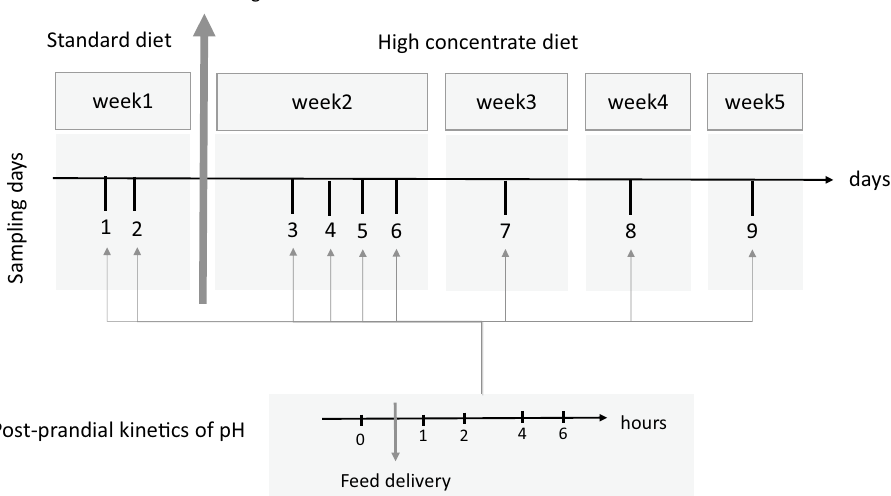
Figure 1. Experimental design. Goats were fed the standard diet in the first week (the first 2 days). Their diet was changed to the high-concentrate diet in the next 4 weeks of experimentation (Days 3 to 9). At each sampling day, pH was recorded before and 1, 2, 4 and 6 h after feed delivery. The presence of two embedded dynamics can be seen in the scheme: one for post-prandial kinetics of pH, the second for the sampling days.